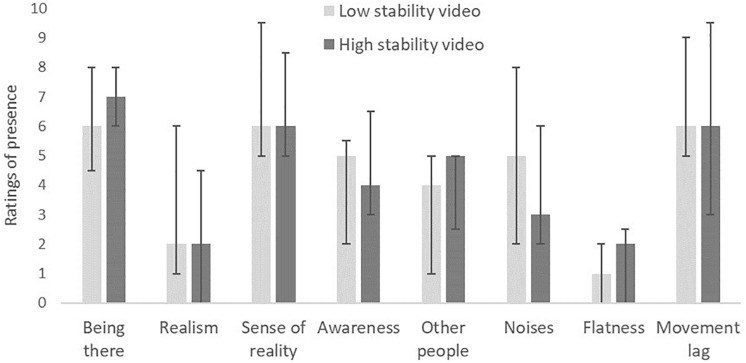
Comparison of ratings of presence associated with exposure to a low- or high-stability 360° video (n = 50; medians and IQRs).